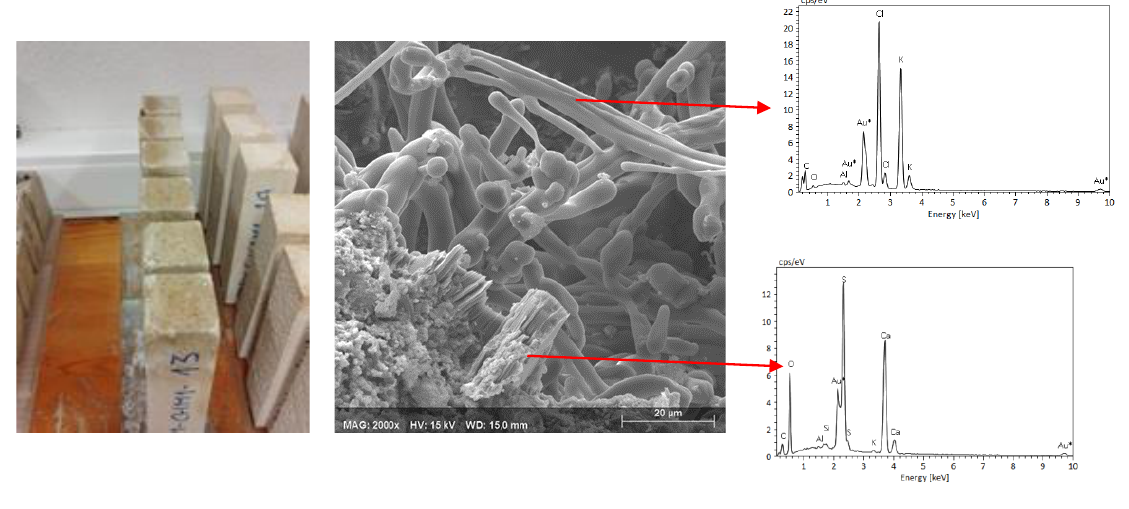
Figure 15. Damaging effect of the samples after the cycles: ( a ) rosy discolouration on the top of the C:A:M 2 and C:A:M 3 specimens and organic elements found at mortar surfaces in SEM observation; ( b ) black mould growth on the top of the A+Q10% and A+Q30% specimens and organic compounds found at mortar surfaces in SEM observation; ( c ) presence of salt efflorescences in the NHL specimens at SEM observation and EDS spectra, where the chemical element gold (Au*) is detected due to be necessary recovering of the samples for the SEM